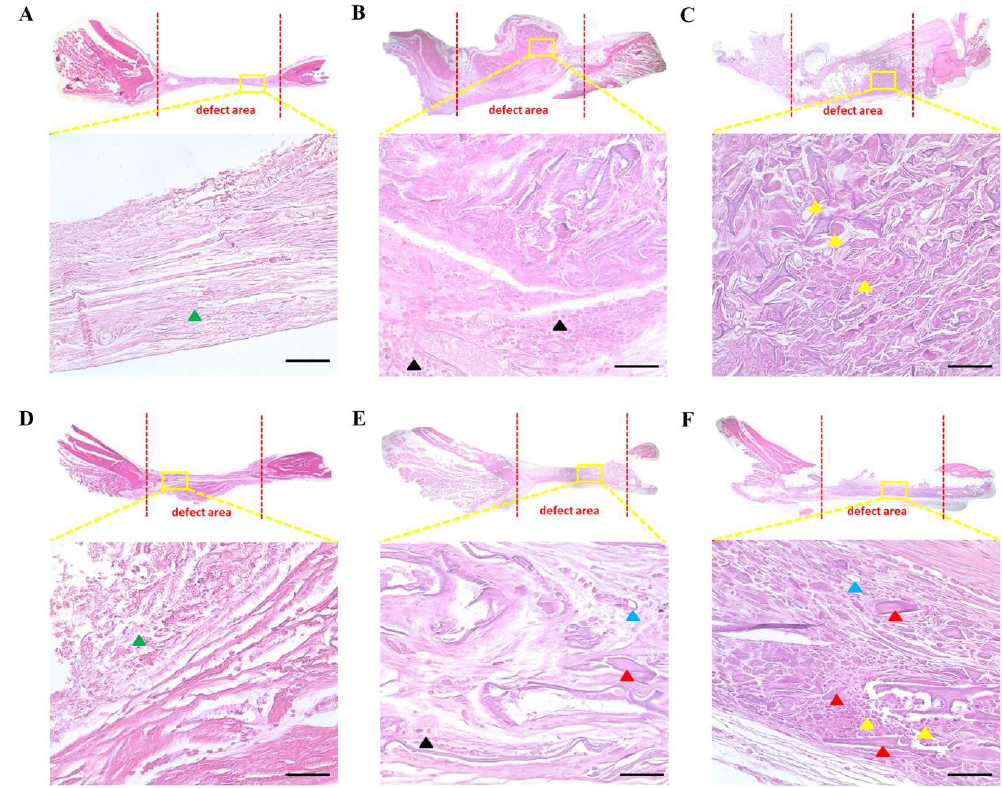
Figure 5. Hematoxylin and Eosin (H&E) staining of rat calvarial defects in the control, implanted SF scaffold, and implanted SF-hASCs scaffold groups. ( A , D ) Control group at six and twelve weeks postimplantation, respectively; ( B,E ) SF group at six and twelve weeks postimplantation, respectively; ( C,F ) SF-hASCs group at six and twelve weeks postimplantation, respectively (green triangle = fibrous connective tissue; black triangle = osteoblast; yellow triangle = osteocyte; red triangle = new bone; blue triangle = blood vessel; scale bar = 50 μm).